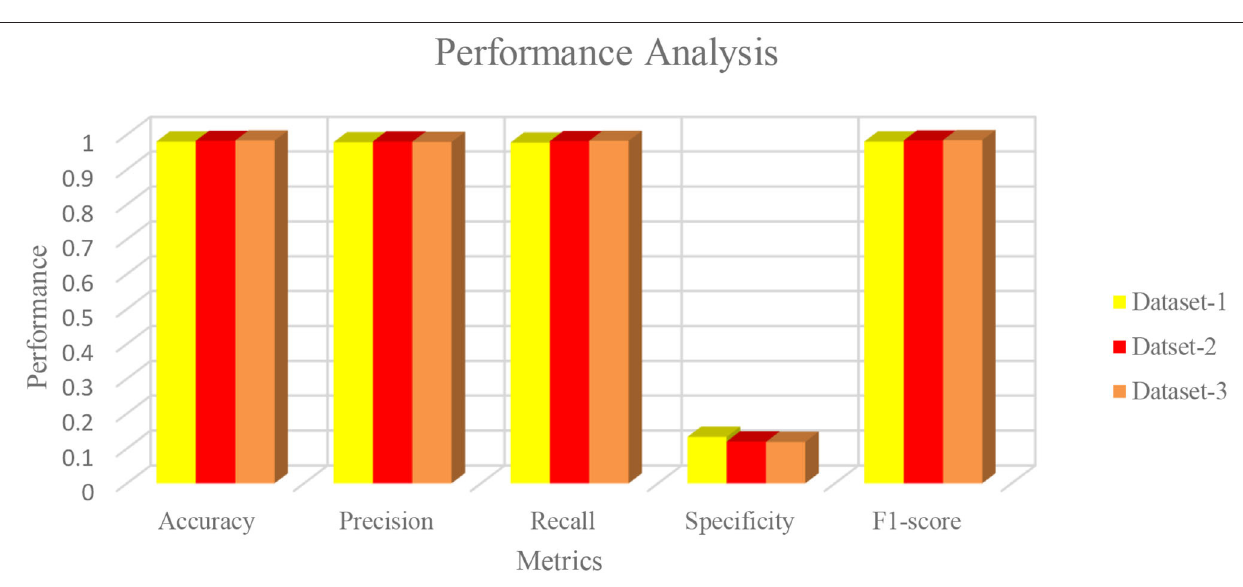
FIGURE 8 | Performance metrics of the proposed algorithm with the different